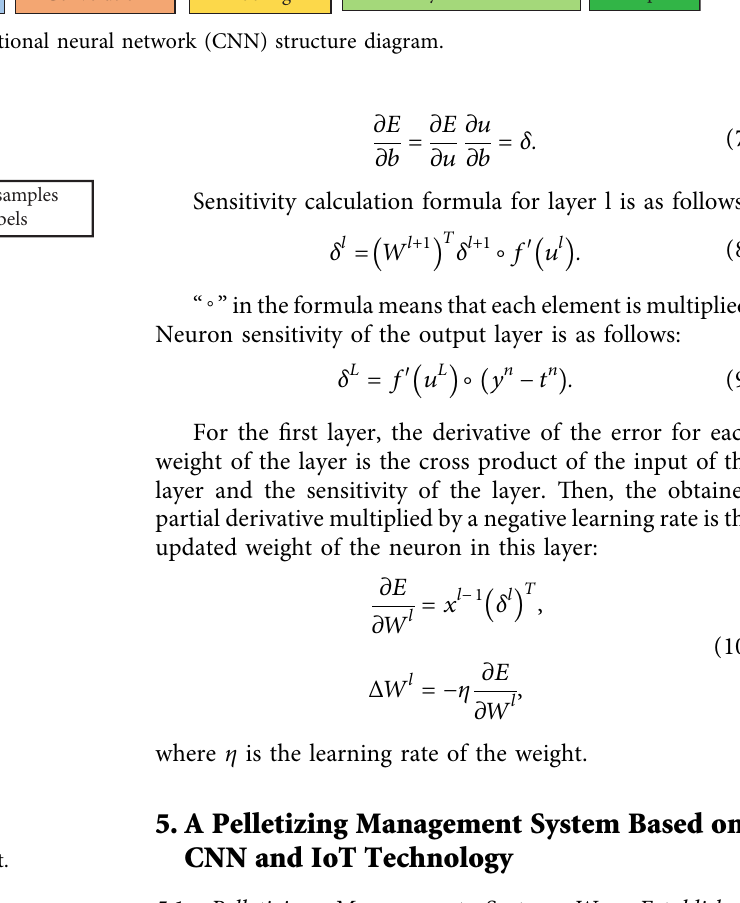
Figure 6: CNN training process flowchart.